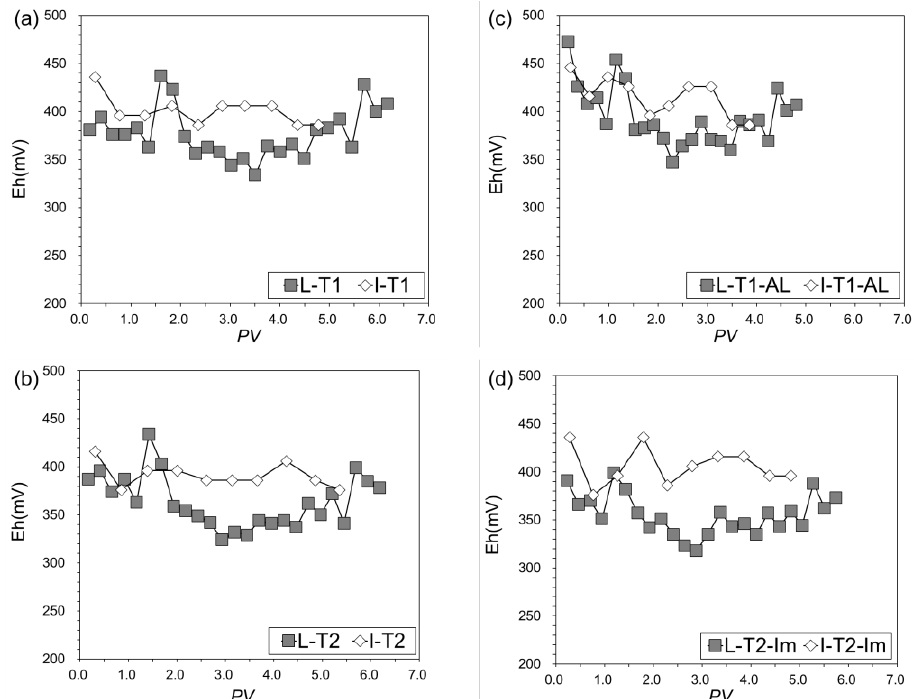
Figure 6. Changes in Eh with PV ; ( a ) comparison between L-T1 and I-T1, ( b ) comparison between L-T2 and I-T2, ( c ) comparison between L-T1-AL and I-T1-AL and ( d ) comparison between L-T2-Im and I-T2-Im.